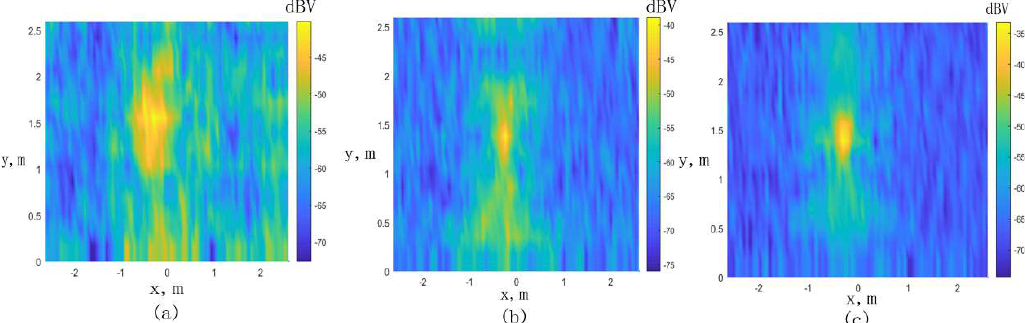
Figure 12. The electric field values of the radiation sources at the same location in different frequencies. ( a ) 2 GHz; ( b ) 5 GHz; ( c ) 6 GHz.